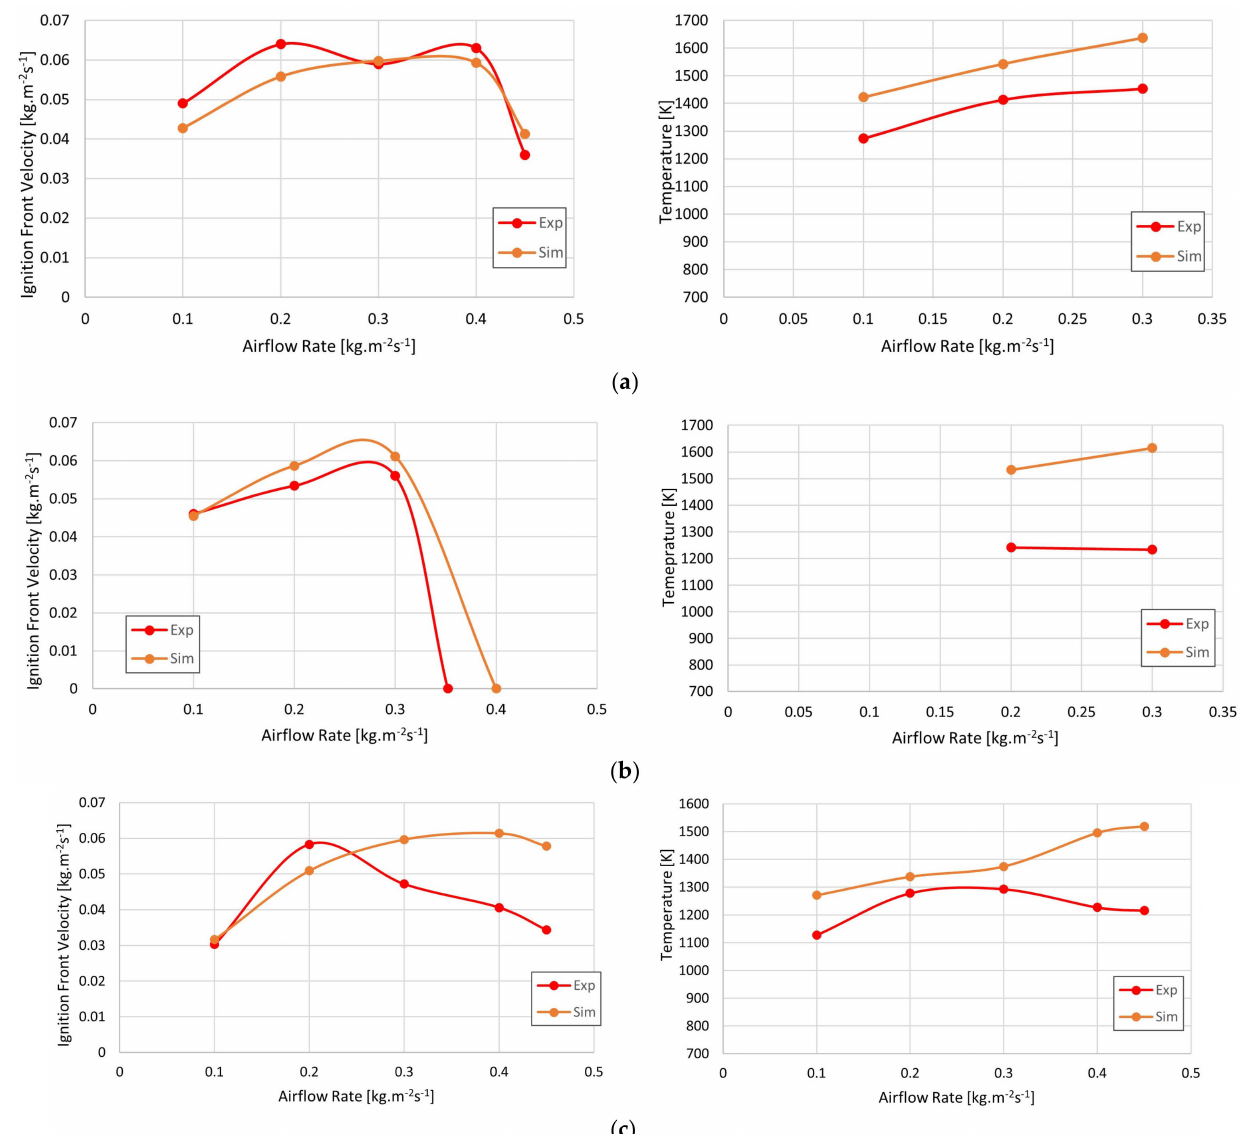
Figure 4. Experimental and simulated curves of ignition front velocity and maximum temperature at different airflow rates: ( a ) wood pellets (wp); ( b ) olive stone (os) and ( c ) almond shell (as).